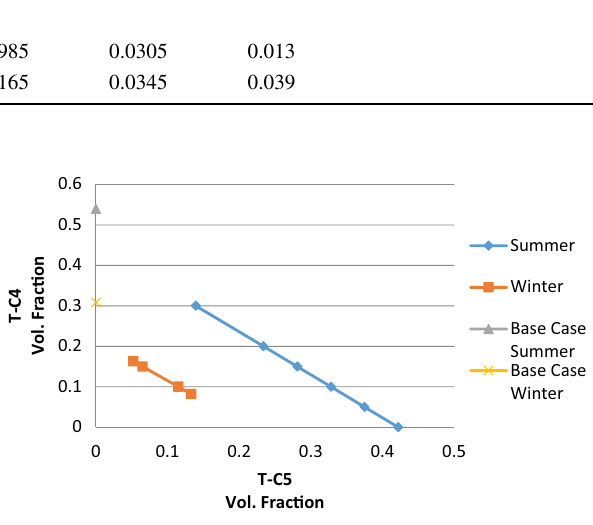
Fig. 40 Effect of adding i-C5, 2,2DMP and 20 vol% DME on LPG heating value